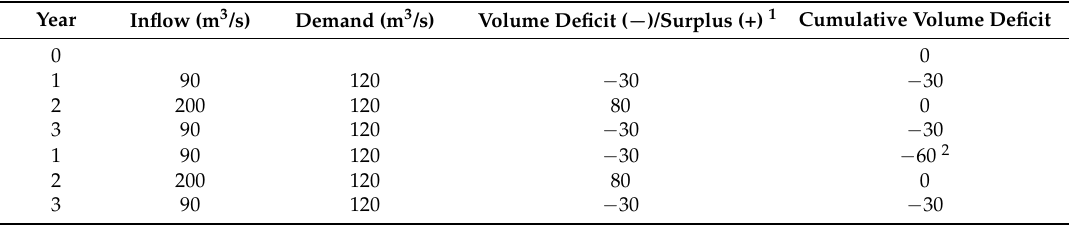
Table 1. Computation of storage capacity for V T >